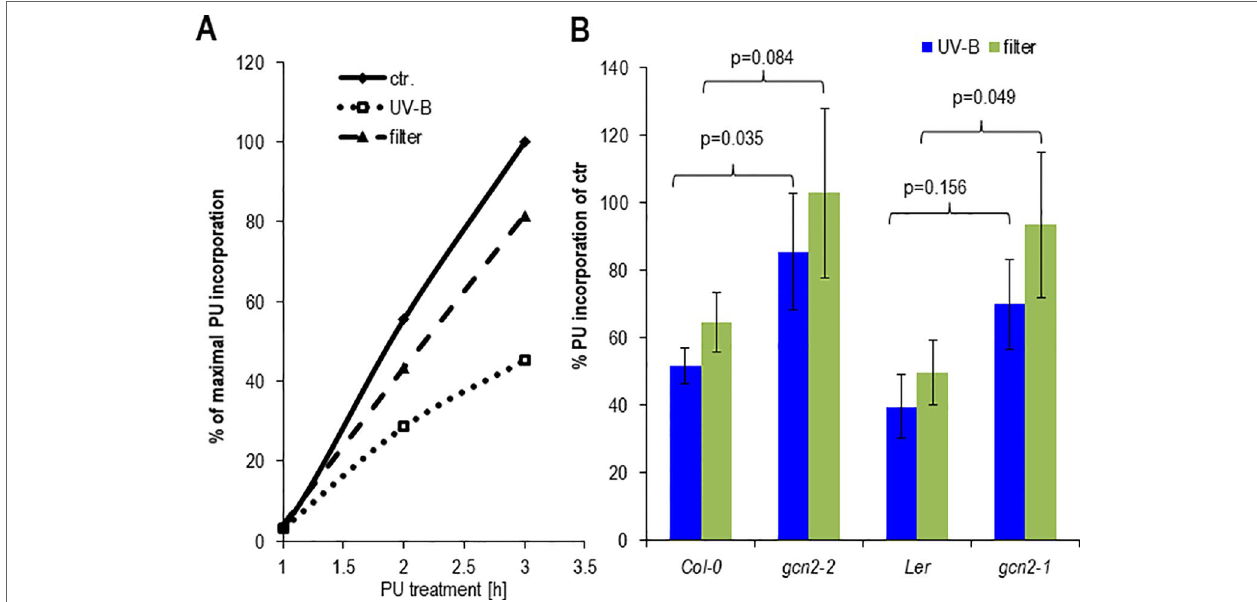
FIGURe 6 | Effects of cellulose acetate filtered and unfiltered UV-B radiation on protein biosynthesis. (A) Time course of PU incorporation of detached rosette leaves. One hundred milligrams per milliliter PU was added at the onset of a 1 h UV-B treatment. Control leaves were only exposed to white light. Leaves were harvested either immediately after UV-B shut down which correspond to 1 or 2, and 3 h after PU addition. (B) Comparison of PU incorporation of wildtype and gcn2 mutants upon UV-B exposure with filtered and unfiltered broad band lamps. In these experiments 100 µg/ml PU was added immediately after UV-B shut down and plant material harvested 1 h later. The graph represents the results of at least three independent Western blots. Error bars represent SE. P-values of student’s t-test are indicated above the brackets.